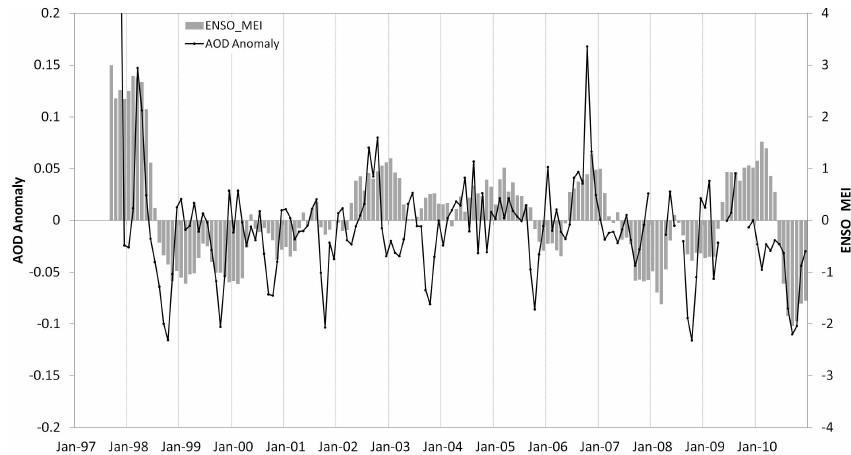
Fig. 4. Time series of AOD anomaly and ENSO Index over Indonesia region (8 ◦ S–8 ◦ N, 90–130 ◦ E).